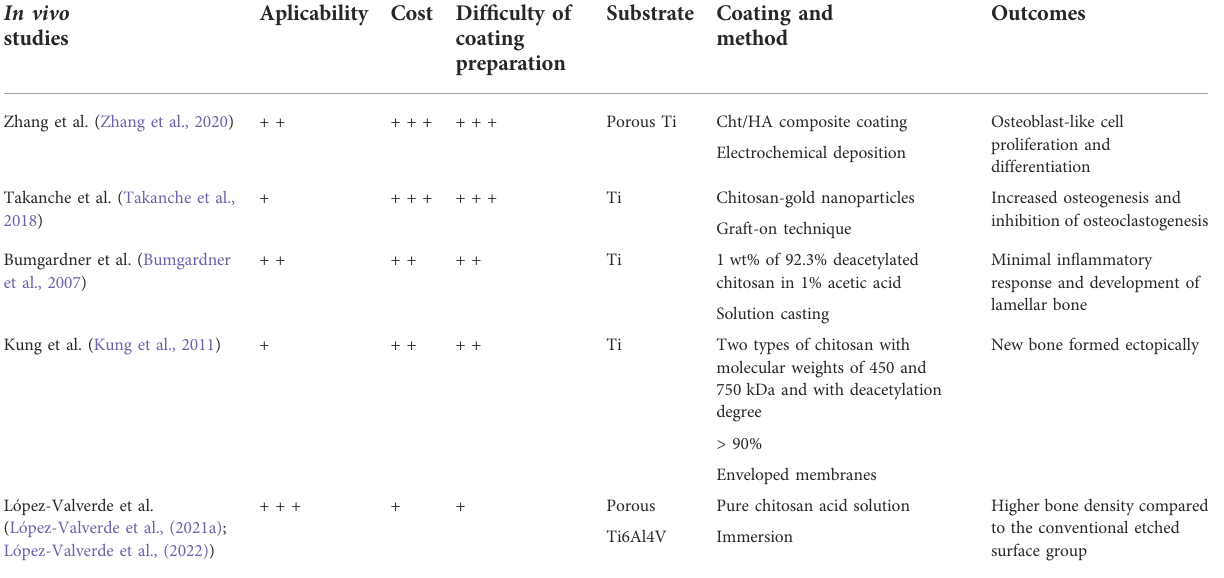
TABLE 2 Characteristics of in vivo